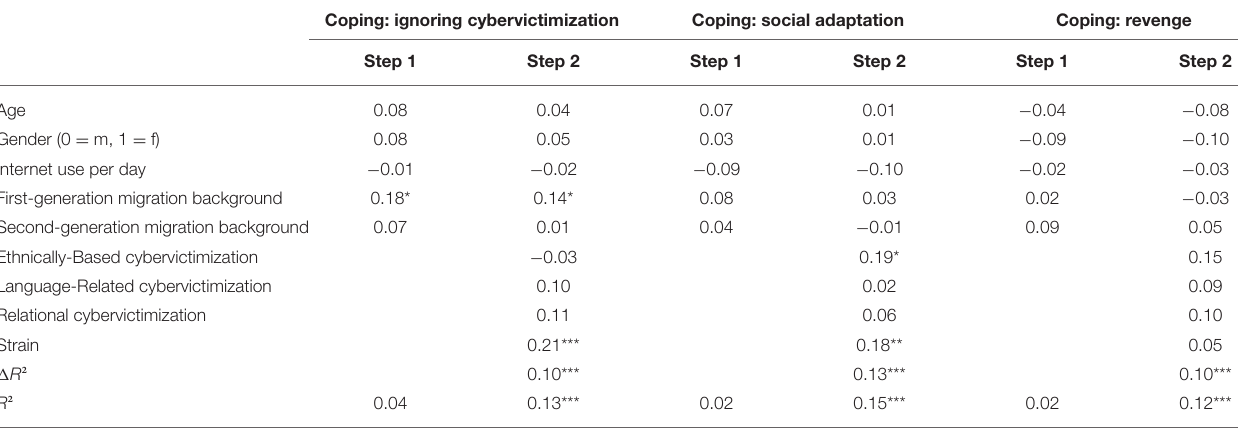
TABLE 4 | Hierarchical regression analysis concerning forms of coping. Coping: ignoring cybervictimization Coping: social adaptation Coping: